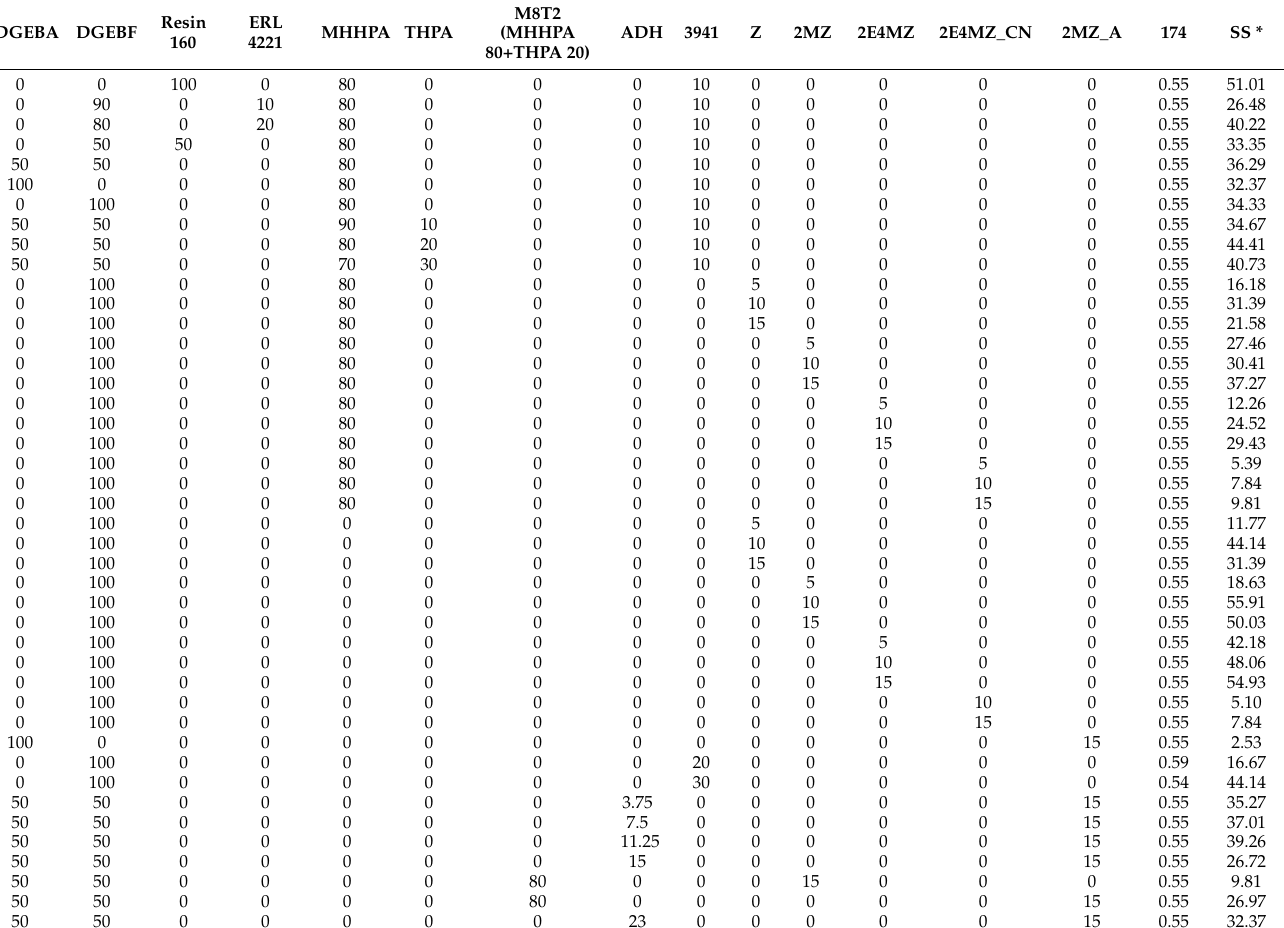
Table A2. Data set for shear strength of